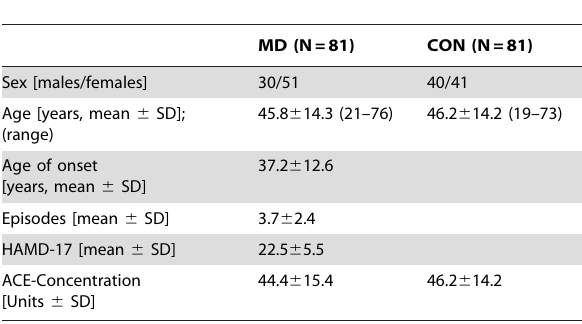
Table 1. Demographic characteristics of the depressed patients (MD) and healthy controls